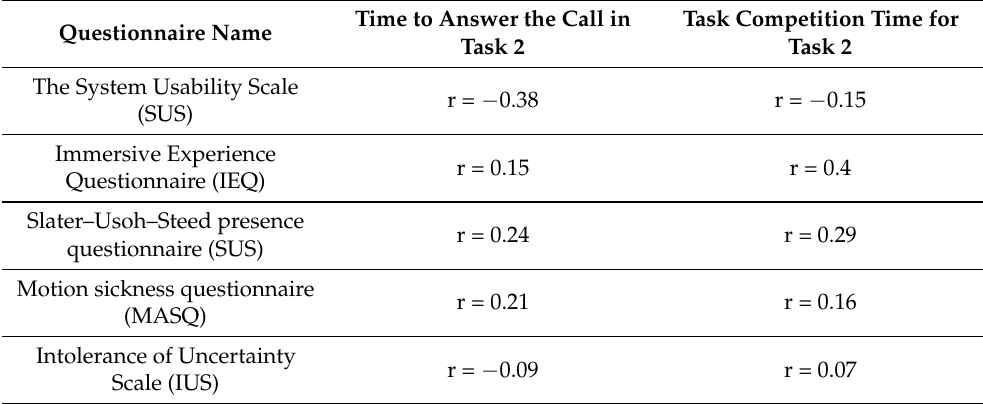
Table 5. Correlation values between subjective and objective measures.